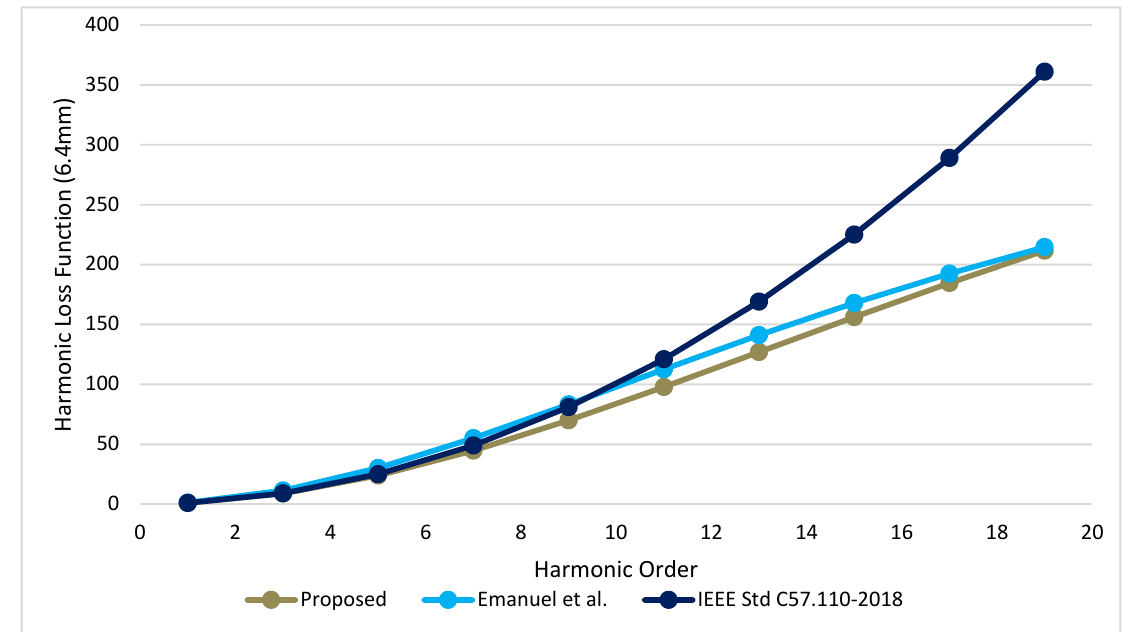
Figure 12. Comparison of the Winding Eddy loss correction functions.